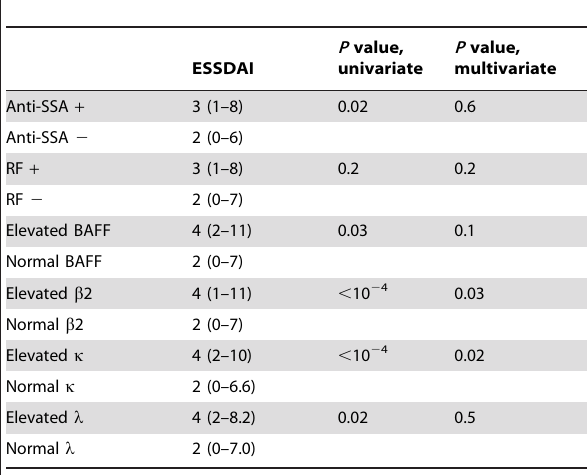
Table 3. Association between autoantibodies, serum markers and